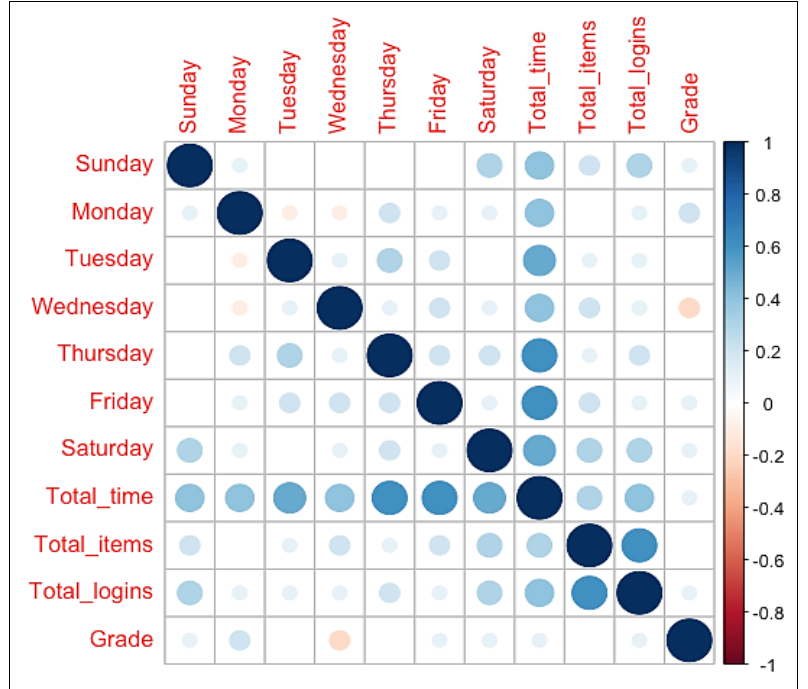
Figure 4. Correlation plot for days of the week and final